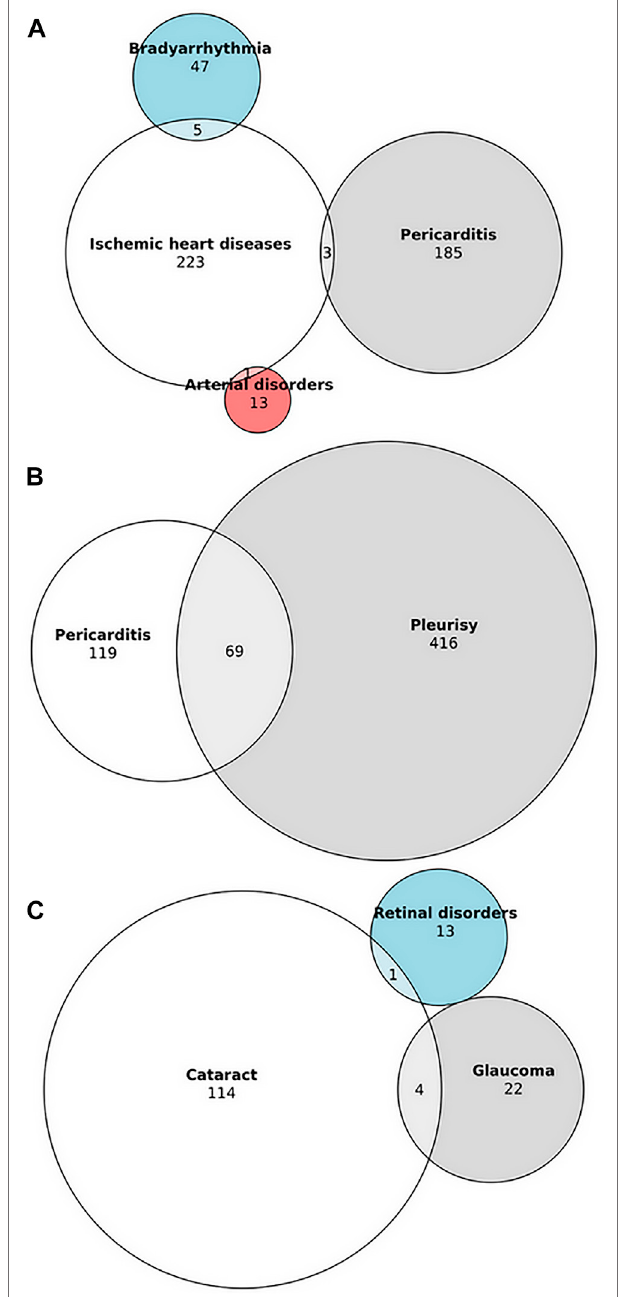
FIGURE 1 | Overlap of cardiovascular, respiratory and ocular serious adverse drug reactions associated with ibrutinib in VigiBase. (A) Overlap between ischemic heart diseases, pericarditis, bradyarrhythmia and arterial disorders. (B) Overlap between pericarditis and pleurisy. (C) Overlap between cataract, glaucoma and retinal disorders. Due to the lack of overlap with other ocular disorders, uveitis is not displayed.